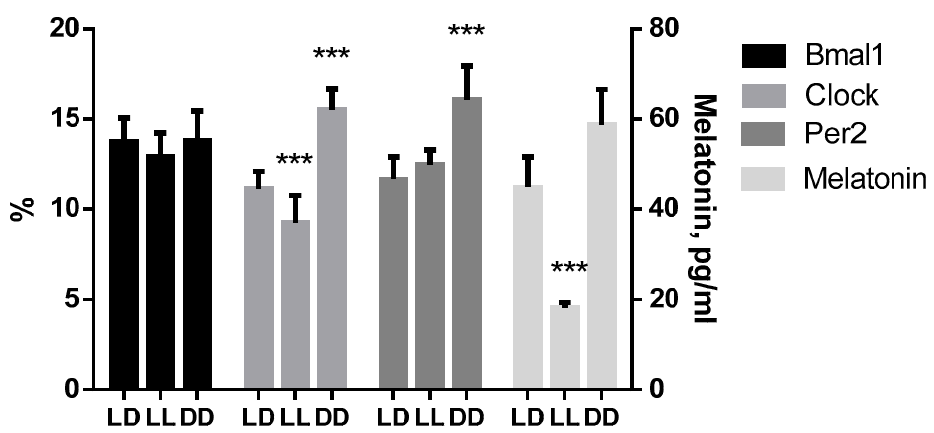
Figure 4. Influence of various light regimes on expression of studied genes. *** ( p ≤ 0.0005)—differences in comparison with the parameters of control group mice.